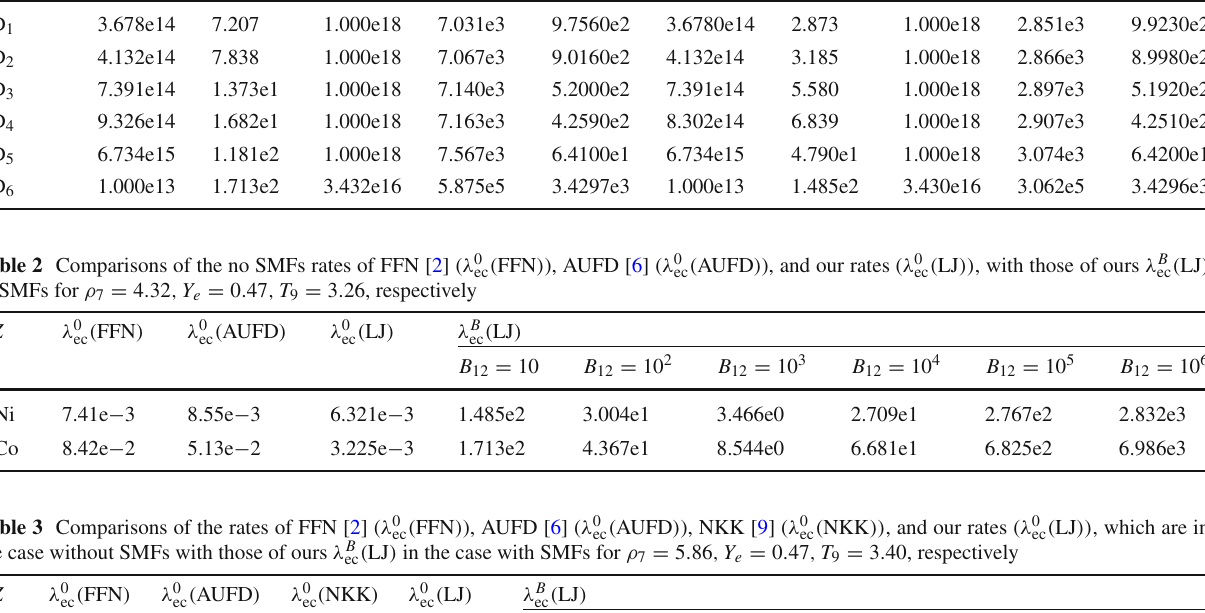
6 . 63 , Y e = 0 . 46 , T 9 = 3 . 51; ρ 7 = 11 . 7 , Y e = 0 . 45 , T 9 = 3 . 73; ρ ( LJ ) for 55 Co, and 56 Ni min